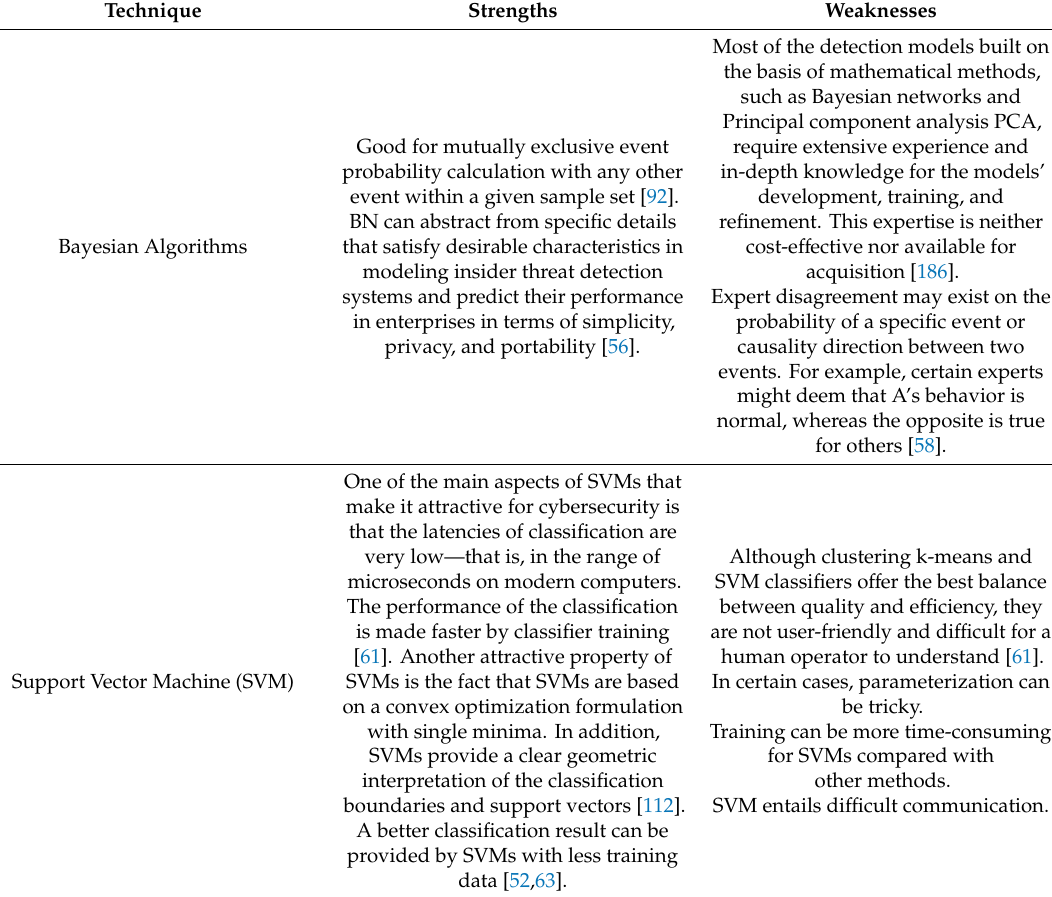
Table 1. Techniques